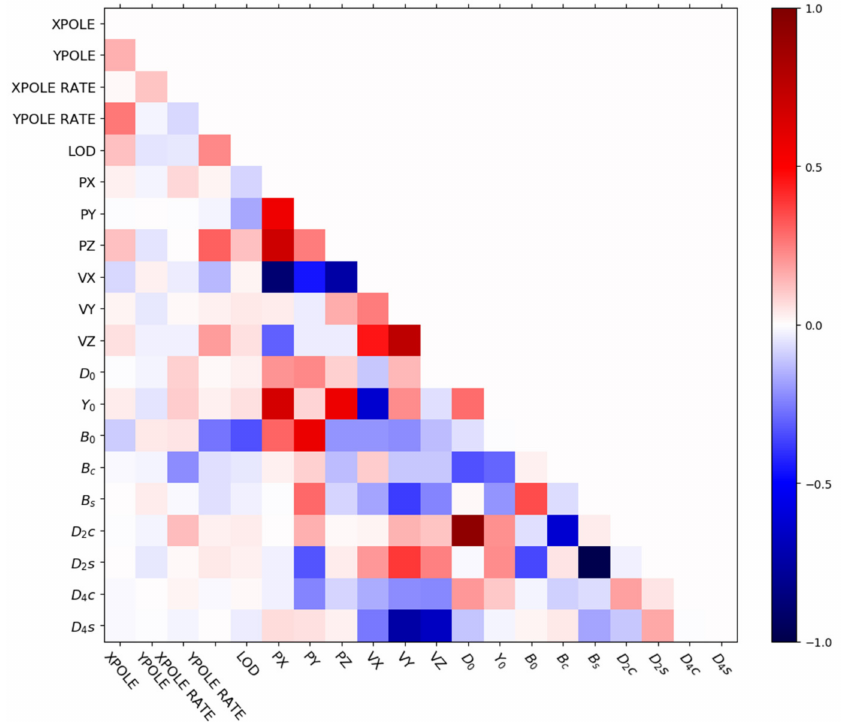
Figure 2. Correlation coefficients between the Earth rotation parameters and the satellite dynamic parameters using the ECOM2 as a parameterization model (E2DYB solution) for G067 (BLOCK IIF) in noneclipsing season ( β ≈ − 34.3 ◦